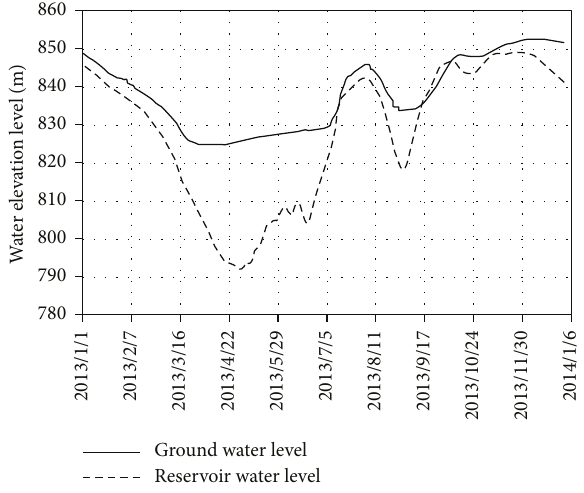
Figure 5: Reservoir water level versus ground water